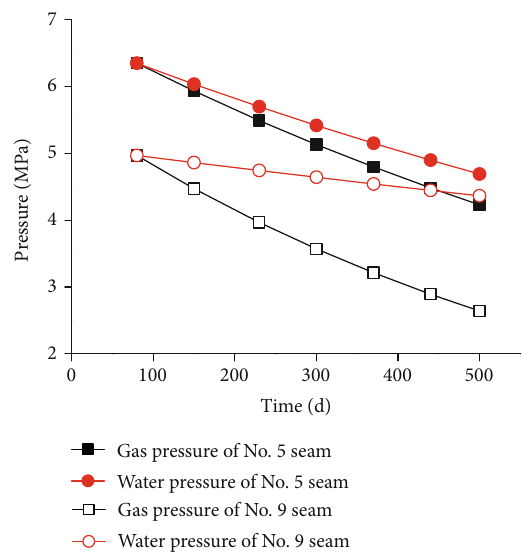
Figure 7: Fluid pressure changes of two coal seams in single coal seam